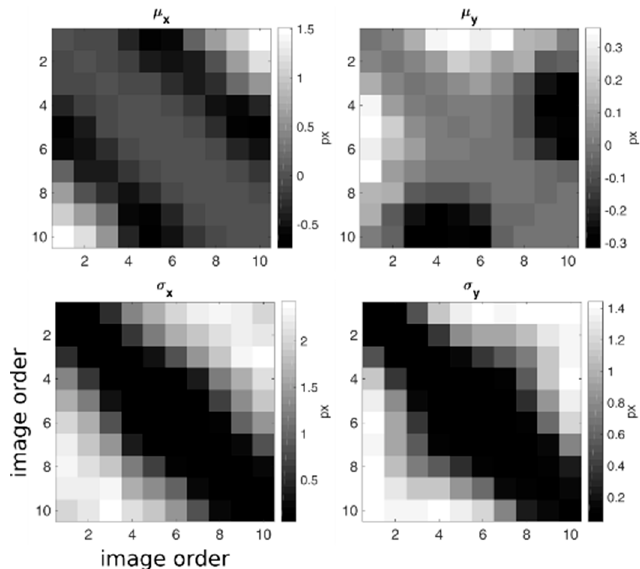
Figure 6. Mean and standard deviation of cross-correlation maps for all possible couples of shaded relief images. The two matrices on the left refer to the horizontal direction and those on the right refer to the vertical. The elements of the matrices correspond to the couples formed from the i th and j th images of a sequence of ten images that were ordered to simulate the motion of the sun during the day.